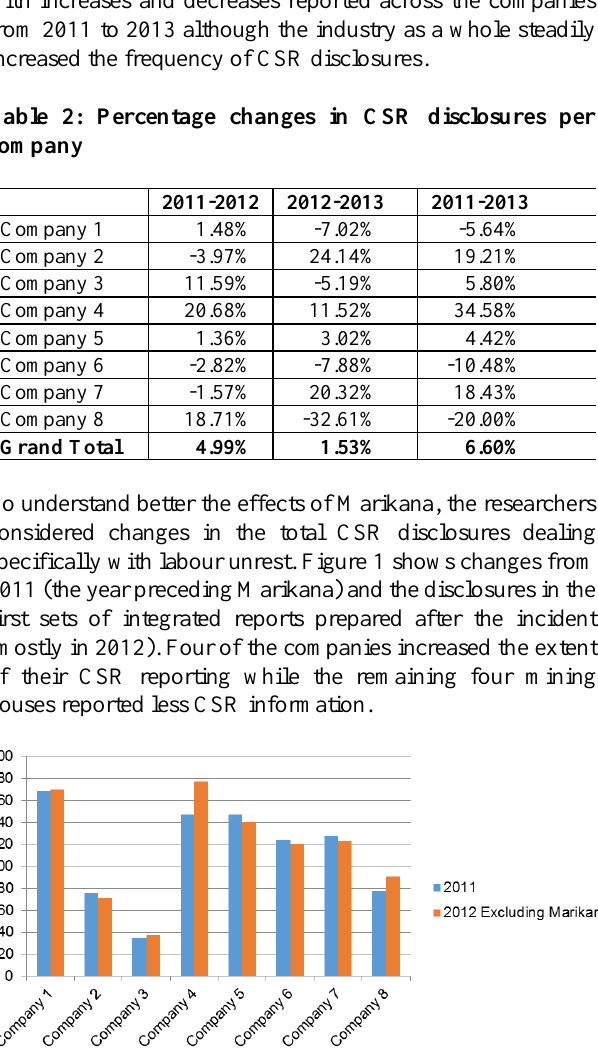
Figure 1: Disclosures excluding Marikana-specific